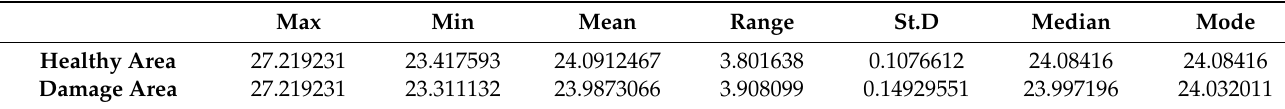
Table 9. Statistical results for thick sample based on transmission mode.